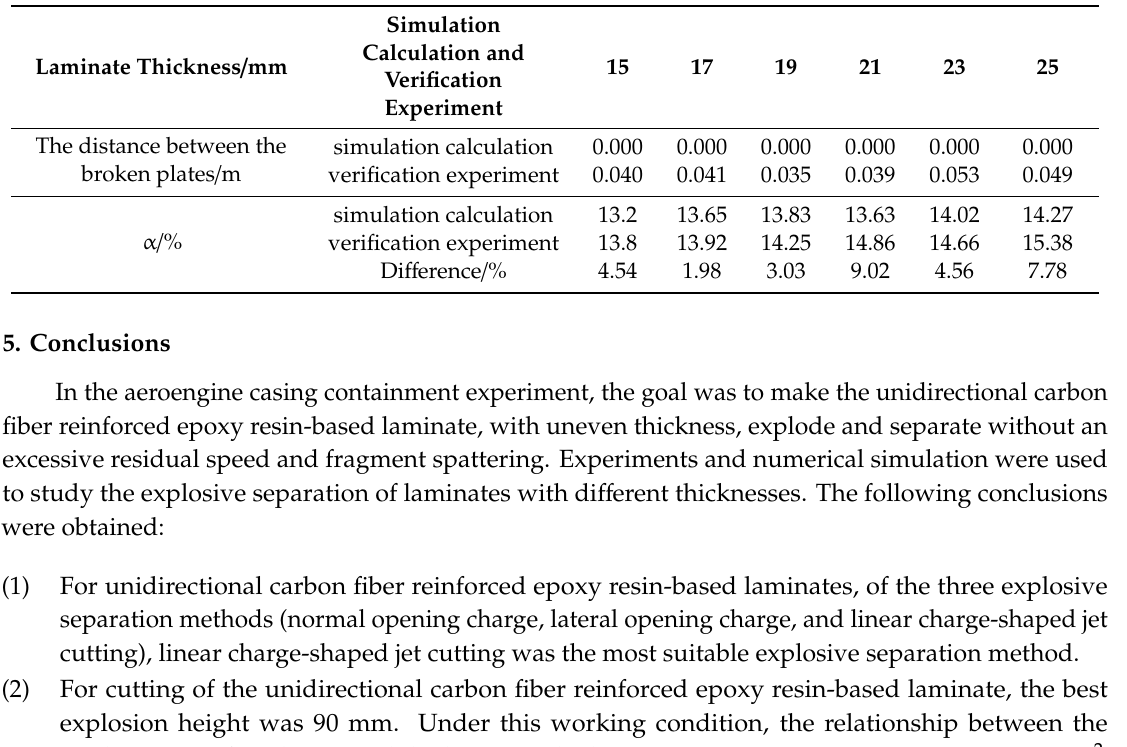
Table 7. Comparison of simulation calculation and verification experimental results.